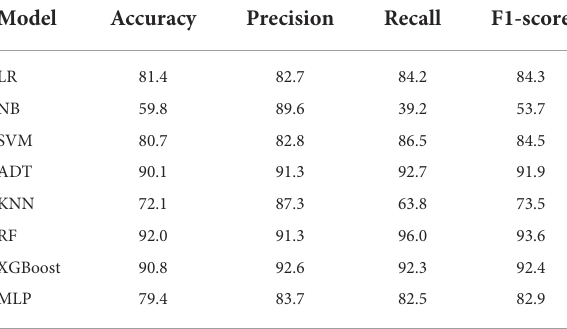
TABLE 4 Machine learning model prediction results on the original